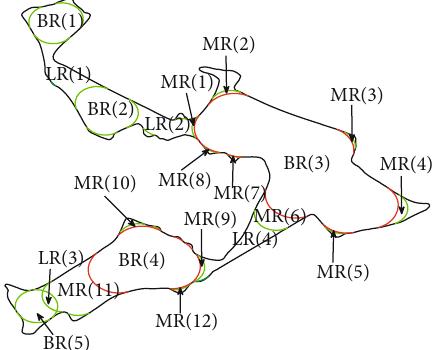
Figure 3: Example illustrating the gas-oil and gas-water AMs (black curve: pore boundary; red curve: gas-oil; green curve: gas-water) and the extracted regions in a pore geometry extracted from Bentheim sandstone ( r = 12 and r = 9 pixel lengths and θ go gw